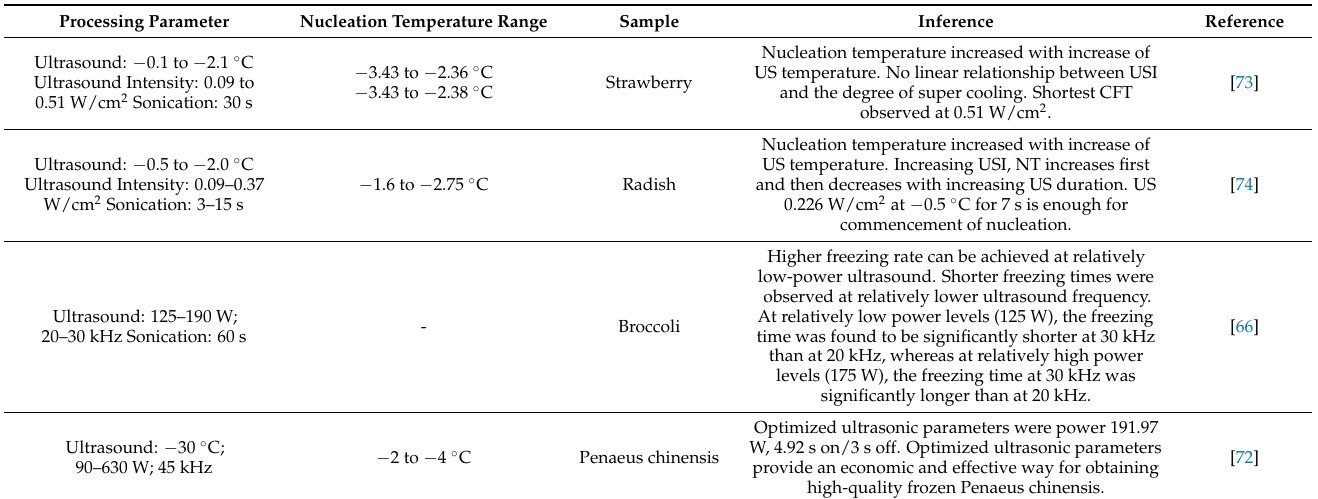
Table 3. Effect of ultrasound during